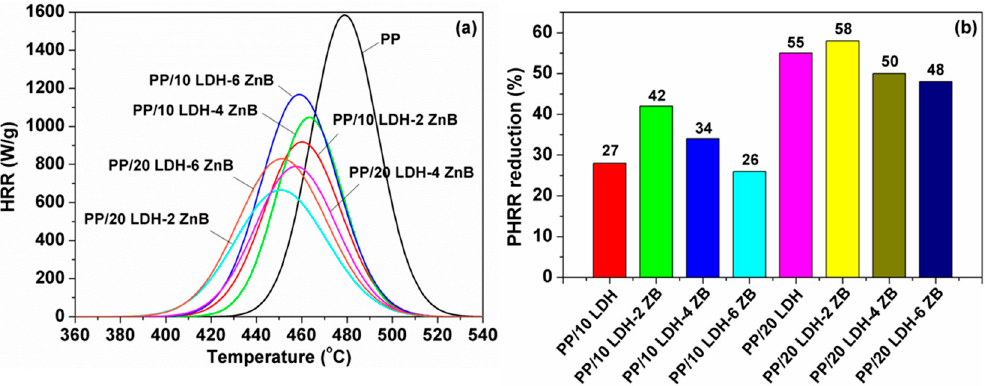
Figure 8. ( a ) HRR curves and ( b ) PHRR reduction of PP and PP/APP-LDH/ZB nanocomposites prepared.